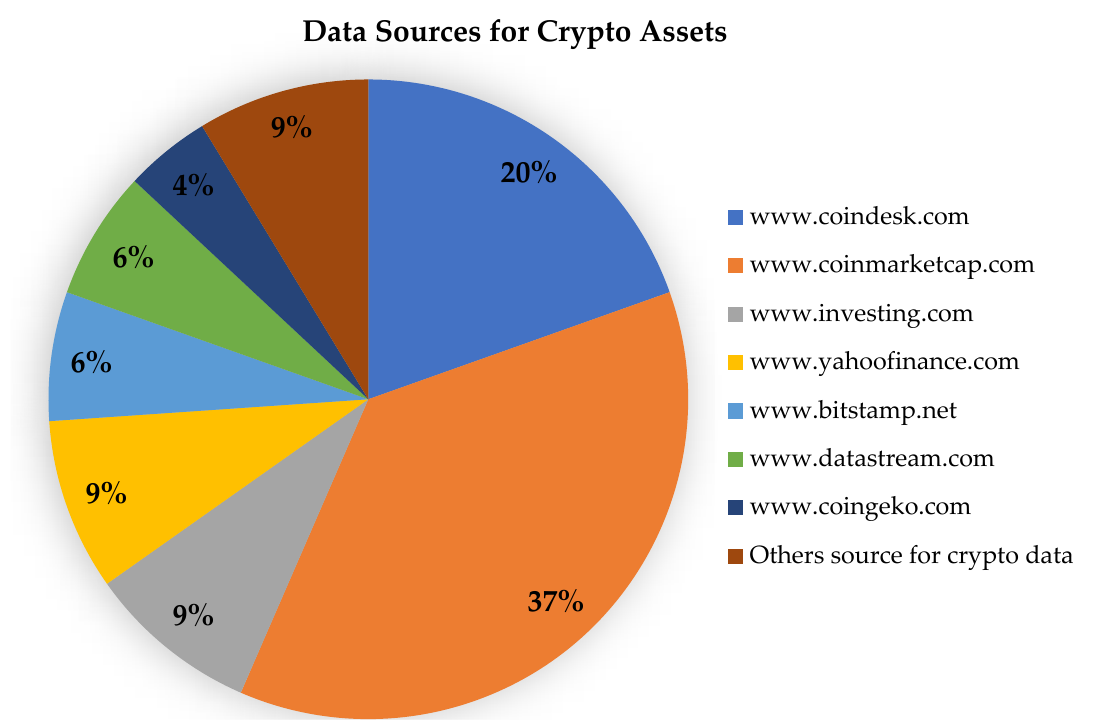
Figure 5. This figure illustrates sources used by previous studies to retrieve the secondary data for cryptocurrencies. The most frequently used platform was www.coinmarketcap.com, covering around 37% of studies data collection source, and www.bitstamp.net is least employed source for cryptos data. Table 4. Data sources utilized in studies.